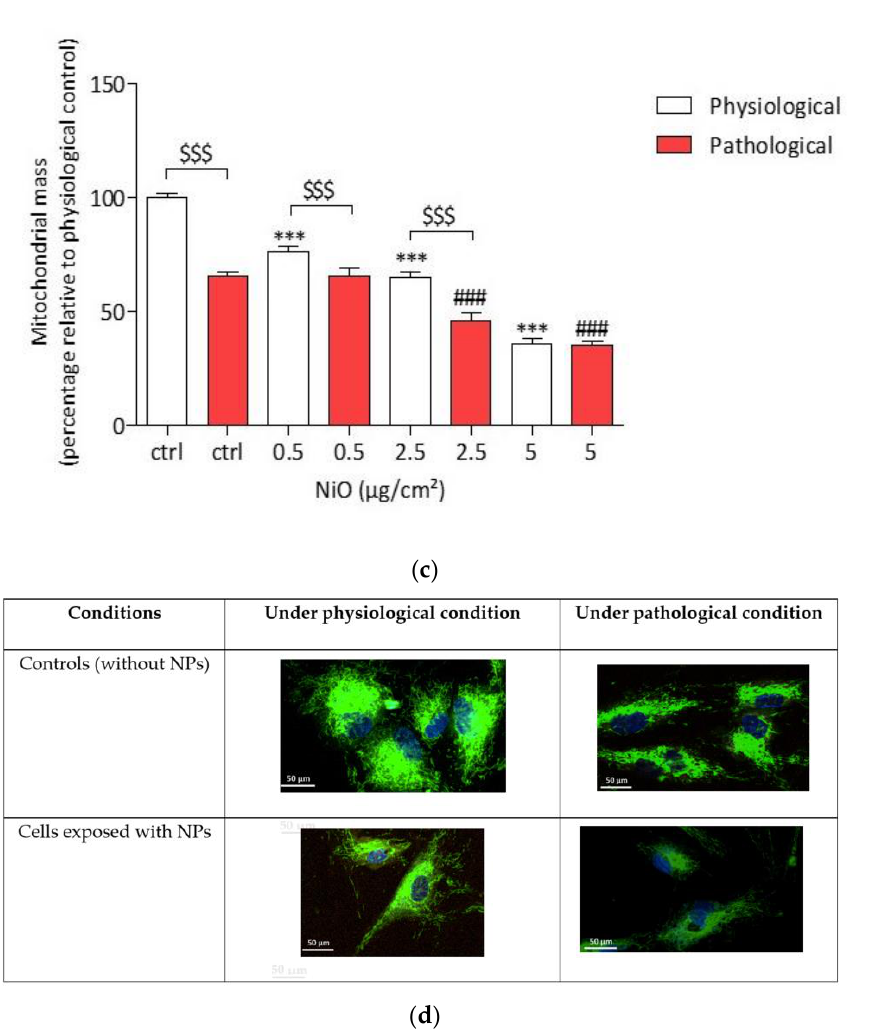
Figure 7. ( a ) Ѱ MP in HPAEC after a 4 h exposure to NiONPs (0.5–5 μg/cm 2 ) in physiological and pathological conditions was measured with TMRM probe (100 nM) by confocal microscopy. ( b ) HPAEC observed by confocal microscopy at focus 60×, under physiological and pathological con- ditions, without or with NiONPs (5 µg/cm 2 ), with Ѱ MP marked in red with TMRM probe and nu- cleus in blue with Hoechst probe. ( c ) Mitochondrial mass in HPAEC after a 4 h exposure to NiONPs (0.5–5 μg/cm 2 ) in physiological and pathological conditions was measured with MitoTracker probe (1 µM) by confocal microscopy. The values were normalized to the untreated physiological cells and results were expressed as the fold change of the probes fluorescence intensity relative to the control cells. ( d ) HPAEC observed by confocal microscopy at focus 60×, under physiological and patholog- ical conditions, without or with NiONPs (5 µg/cm 2 ), with mitochondrial mass marked in green with MitoTracker probe and nucleus in blue with Hoechst probe. Data were mean ± SEM of three inde- pendents experiments ( n = 3) performed in quadriplicate. *** p < 0.001 vs. untreated cells in 0% CS in normoxic conditions. ### p < 0.001 vs. untreated cells in pathological conditions. $$$ p < 0.001 between both conditions. According to one-way ANOVA followed by Tukey’s post hoc test for mul- tiple